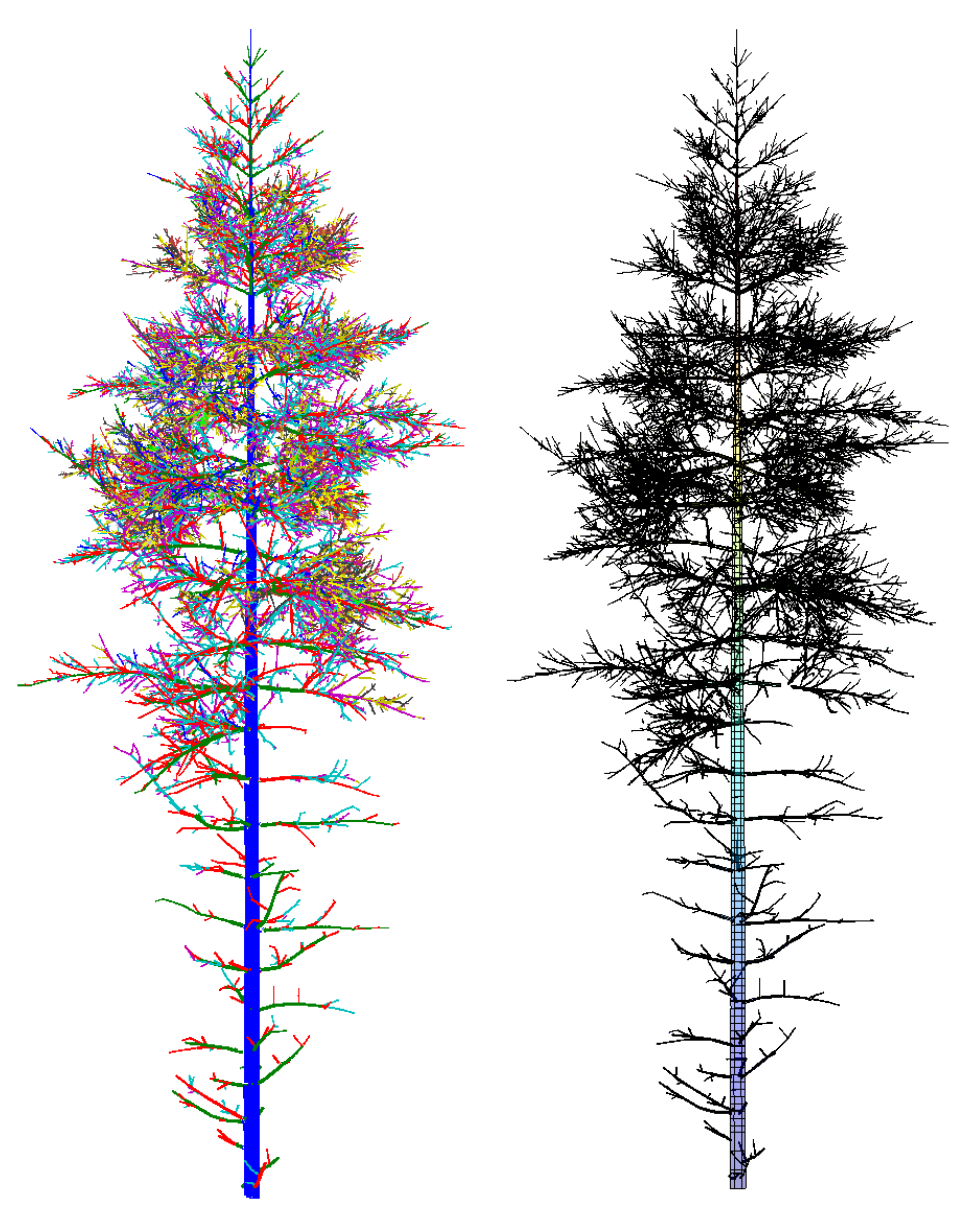
Figure 1. Segmented point cloud ( left ) and the final cylinder model ( right ) of the artificial Scots